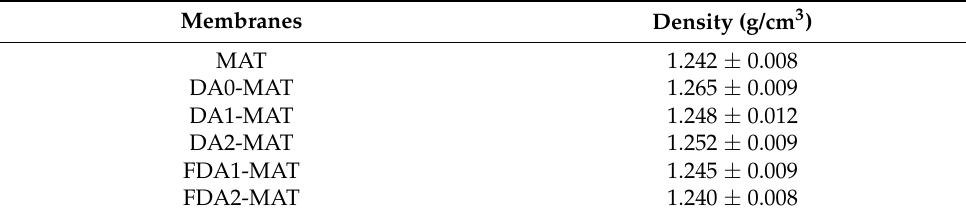
Table 4. The density of diamine-modified Matrimid